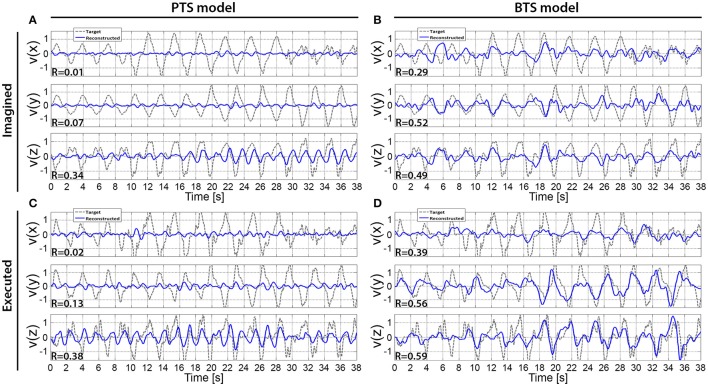
Reconstructed hand velocity vector components of single kinematic trials. V(x), v(y), and v(z) velocity vector components are matched with executed or imagined movement in horizontal, vertical, and depth directions, respectively. For the imagined movement reconstruction (A,B), the target trajectory was calculated based on executed arm movement trials that were registered using the experimental protocol that was used for the run with imagined arm movements. The imagined arm movement velocity reconstruction is presented in (A,B) for the PTS and BTS models, respectively. The executed arm movement velocity reconstruction is presented in (C,D) for the PTS and BTS models, respectively. (A,B) are calculated based on subject 2, run 4, and outer fold 1 using the time-resolved low delta (0–2 Hz) band-pass filtered EEG for (A) and PSD of the low gamma (28–40 Hz) band for (B), while (C), and (D) are calculated based on subject 2, run 2, and outer fold 1 using the time-resolved low delta (0–2 Hz) band-pass filtered EEG for (A) and the time-resolved PSD of the low beta (12–18 Hz) band for (D).